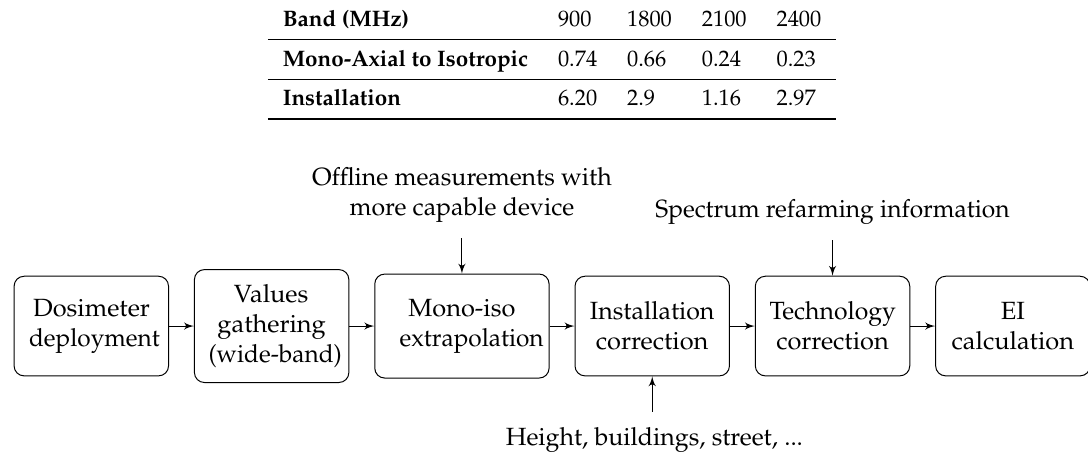
Figure 9. Exposure Index ( EI ) calculation in a smart city